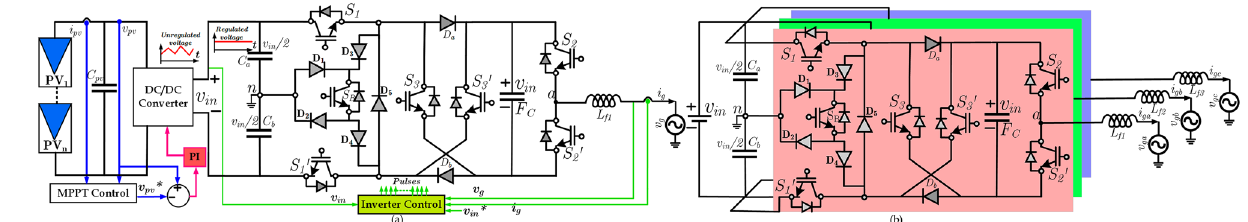
Figure 8. Proposed RSC-SB2 topology with ( a ) PV and simple grid control structure and ( b ) three-phase system